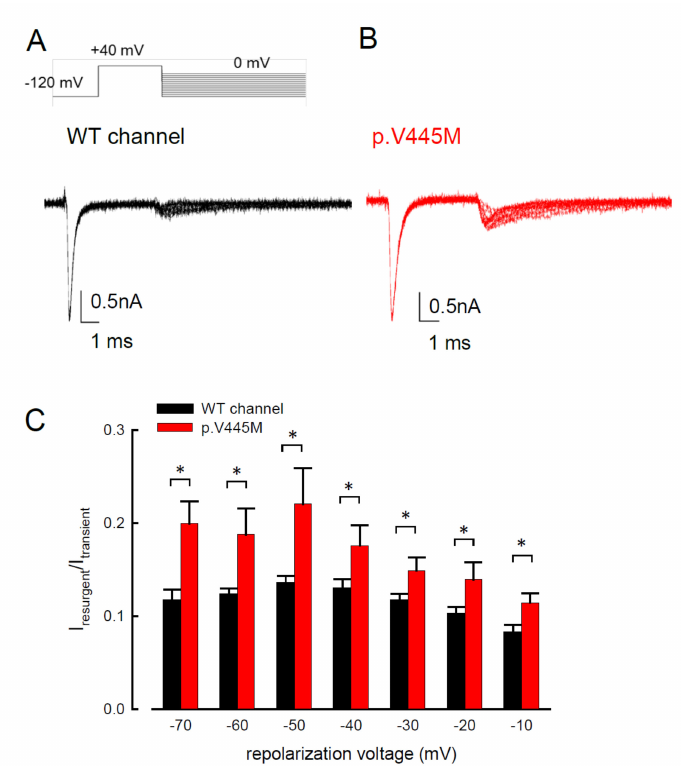
Figure 4. Smaller resurgent Na + currents in the WT channel than that in the p.V445M mutant channel in the CHO-K1 cells ( A ) The protocol to generate resurgent Na + currents is as follows: the patched cells were held at − 120 mV, and the resurgent Na + currents of the WT channel were evoked by pulses following a depolarization prepulse of + 40 mV for ~10 ms in the presence the Na v β 4 peptide (upper panel). Sample sweeps for the WT channel show the occurrence of resurgent Na + currents at ~4 ms post repolarization in the presence of 100 µ M Na v β 4 peptide (lower panel). ( B ) Sample sweeps for